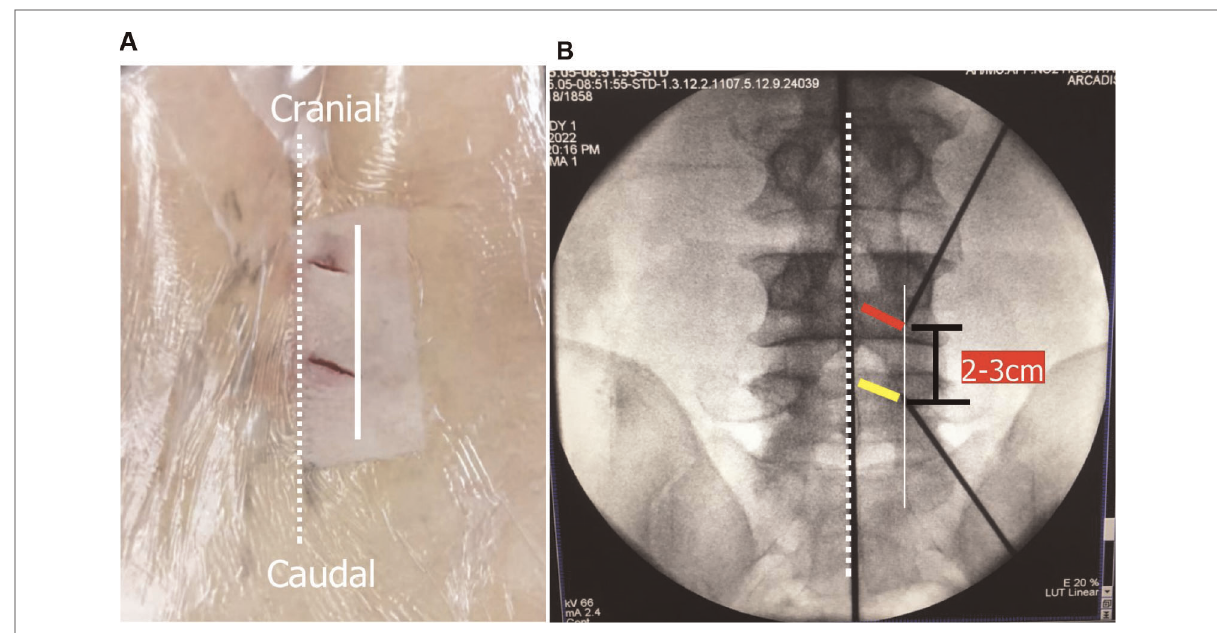
FIGURE 3 Initial placement of two portals and related anatomy. ( A ). Skin entry points for two portals; and ( B ) position of two portals on an anteroposterior view of x-ray (yellow line: the site for placement of the cranial portal; red line: the site for placement of the caudal portal; dotted line: midline; white line: medial pedicular line).